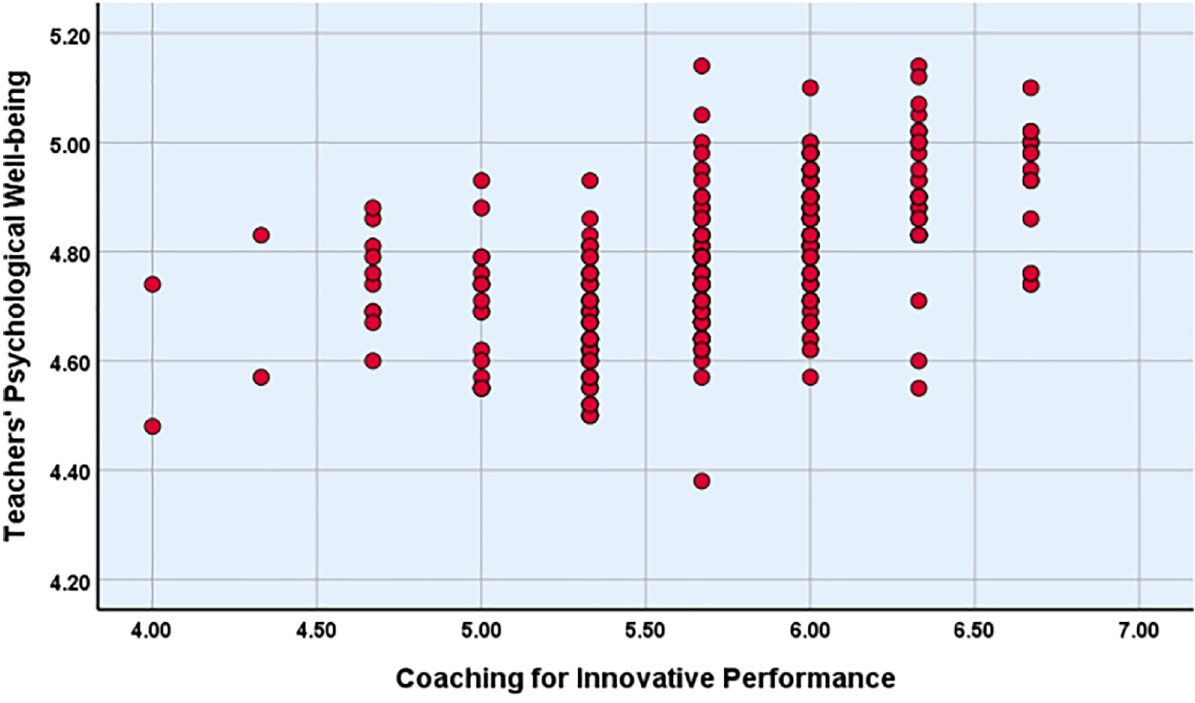
Fig 8. Pearson’s product-moment correlation between coaching for innovative performance and teachers’ psychological well-being. The scatterplot plainly indicates the significant positive relationship between coaching for innovative performance (subdomain of leadership empowering behaviour) and teachers’ psychological well-being at secondary level.